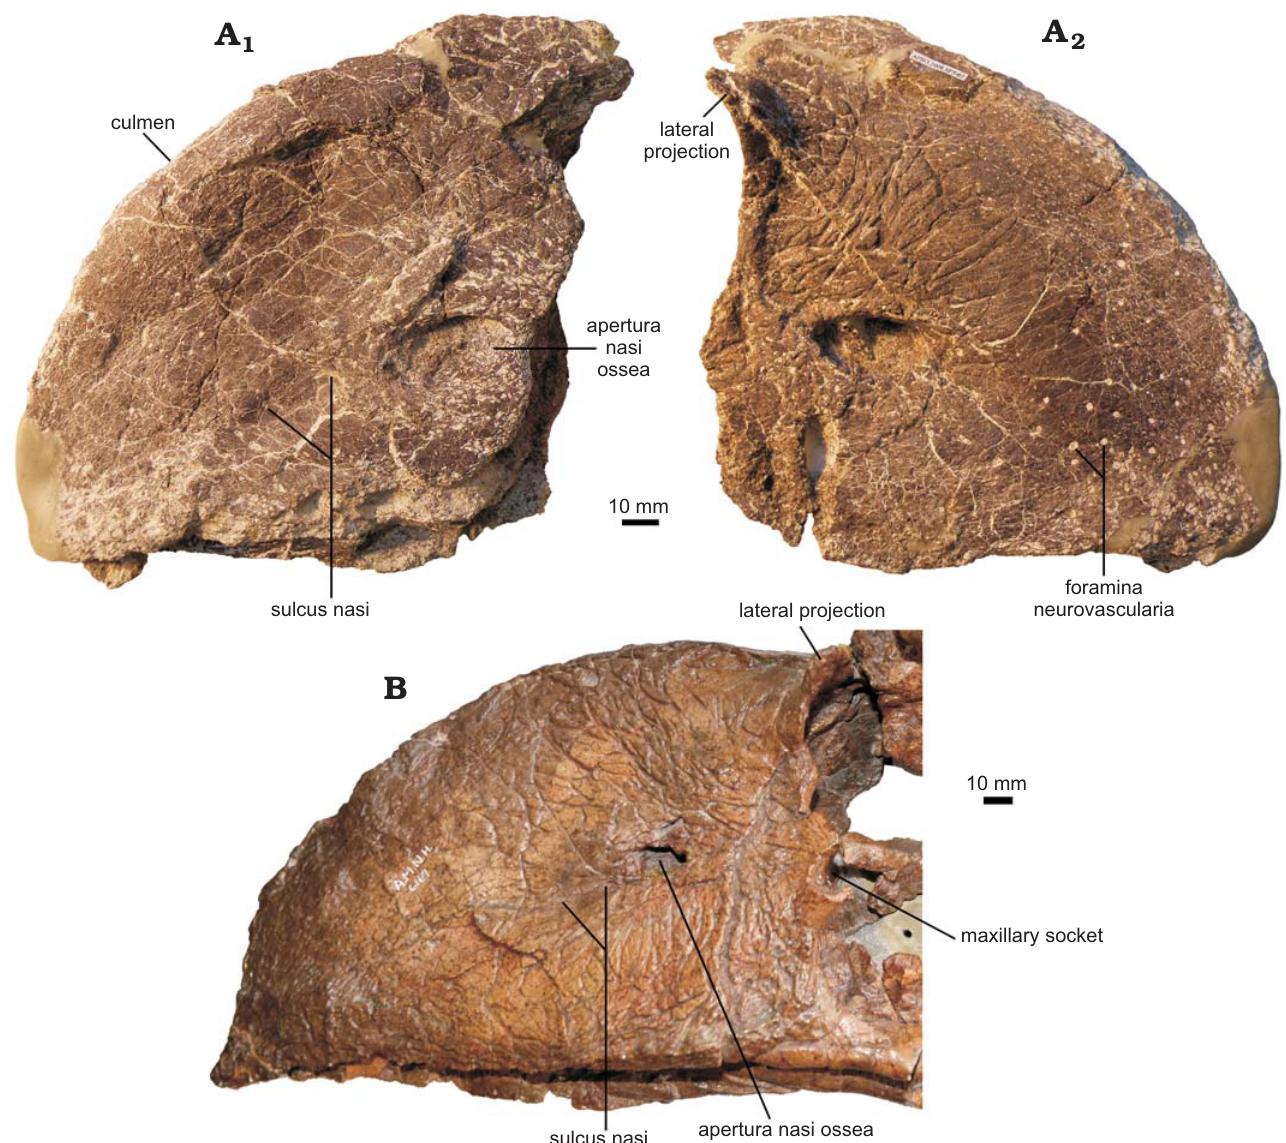
Fig. 1. Maxilla of early Eocene gastornithid birds. A . Gastornis parisiensis Hébert, 1855 MHNT.PAL.2013.15.1, La Borie, France, in left (A (A ) lateral views. B . Gastornis giganteus (Cope, 1876) AMNH6169, Willwood Formation, Wyoming, USA, in left lateral 2